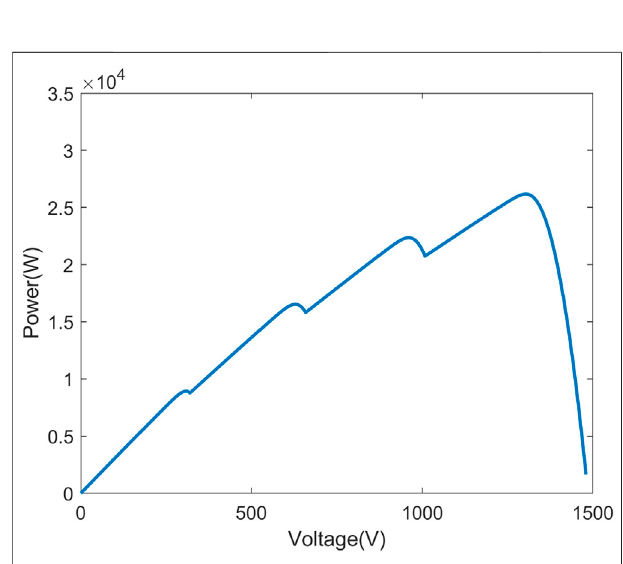
FIGURE 9 | Startup response of the fuzzy adaptive PSO and the convential PSO MPPT for irridiation 2.